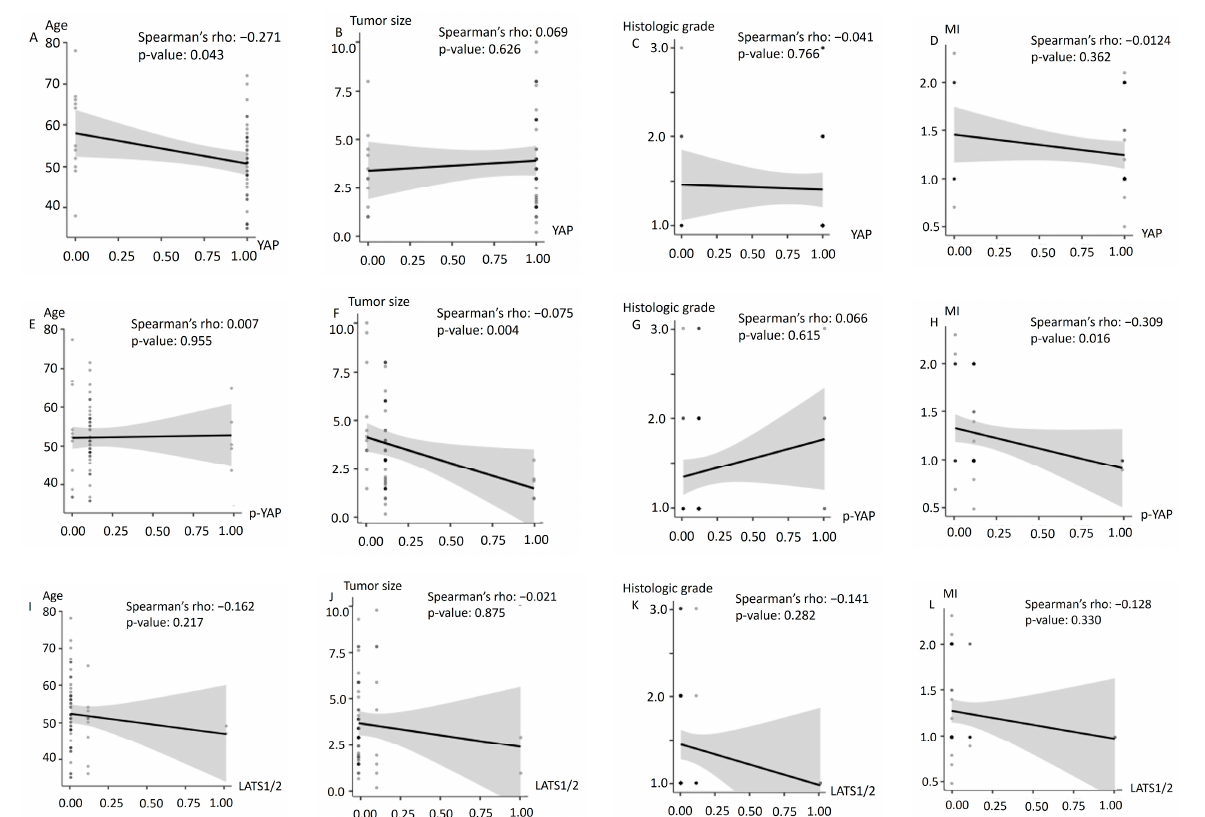
Figure 2. The Spearman correlation coefficient with the p -value. ( A,F,H ) showed an inverse corre- lation (Spearman correlation coefficient = − 0.271, − 0.375, − 0.309 and p -value = 0.043, 0.004, 0.016, respectively). ( B – E , G , I – L ) showed no correlation between two